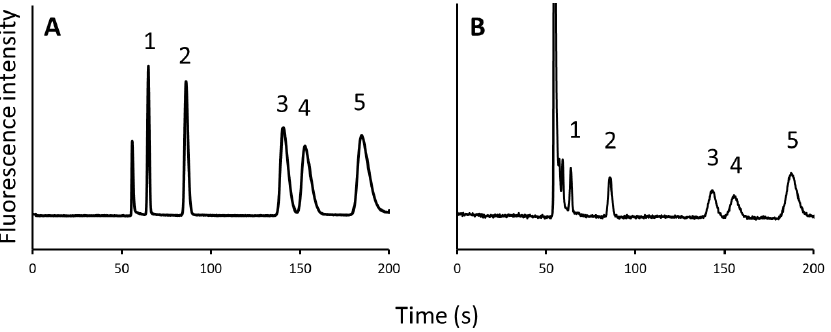
Figure 3 . Chromatograms of ( A ) 5 kinds of NBD – amino acids and ( B ) human plasma sample. Peak: 1, NBD – Pro; 2, NBD – Val; 3, NBD – Ile; 4, NBD – Leu; 5, NBD – Phe